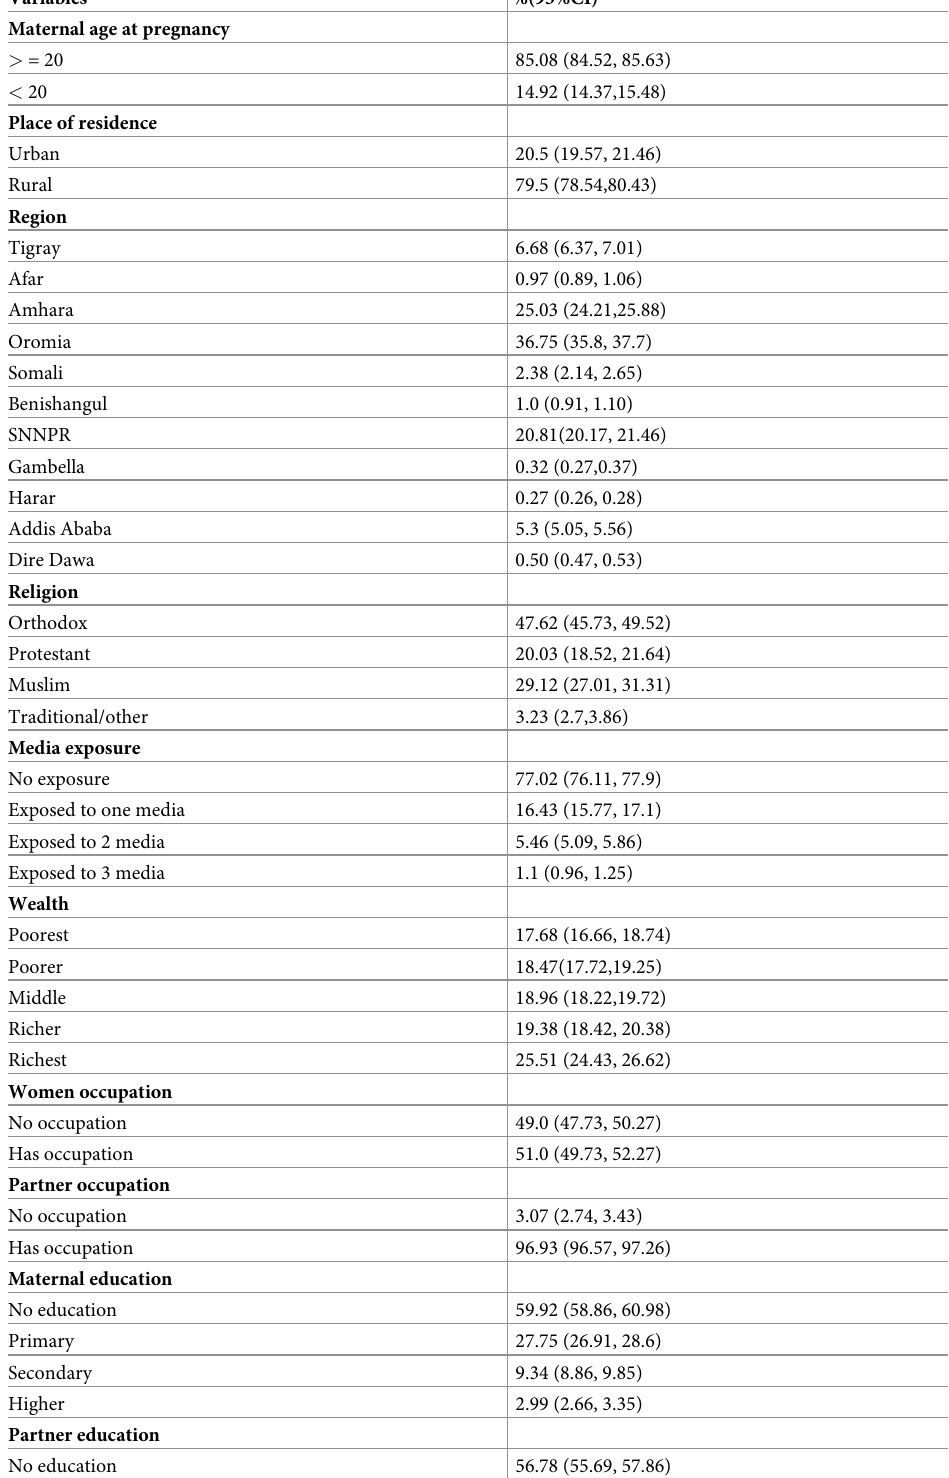
Table 1. Sociodemographic characteristics of the sample, 2000–2016